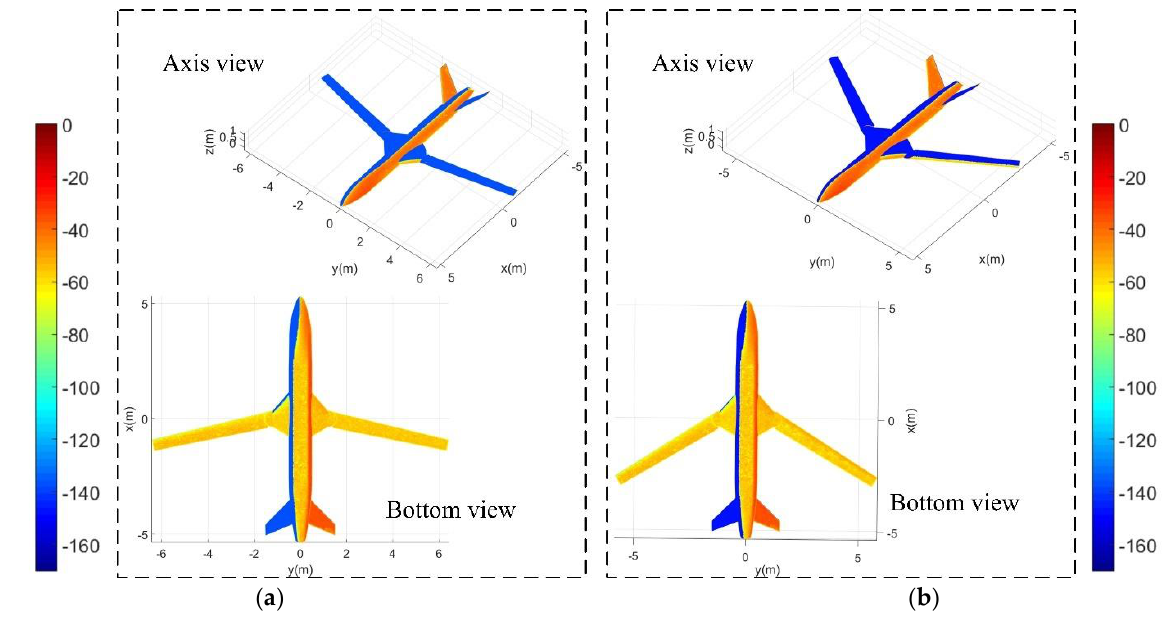
Figure 18. Surface scattering characteristics of the aircraft, where F r =5 GHz and β = − 10°. RCS unit: dBm 2 . ( a ) Case at α = 103° and A s = 11.37°. ( b ) Case at α = 86° and A ss = 30.4401°. For the case where α = 8 6°, the aircraft adopted the automatic sweepback scheme.